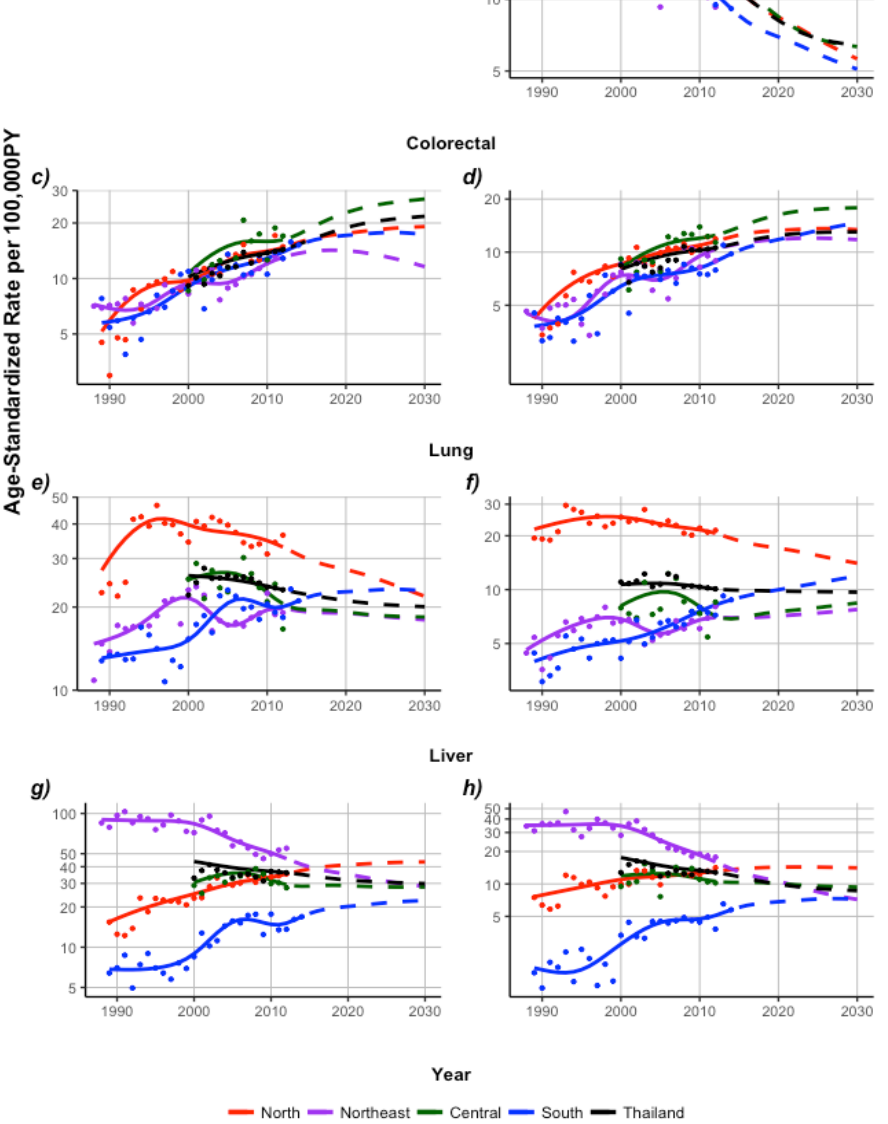
Figure 7 . Projections of cancer trends for males and females by cancer Figure 7. Projections of cancer trends for males and females by